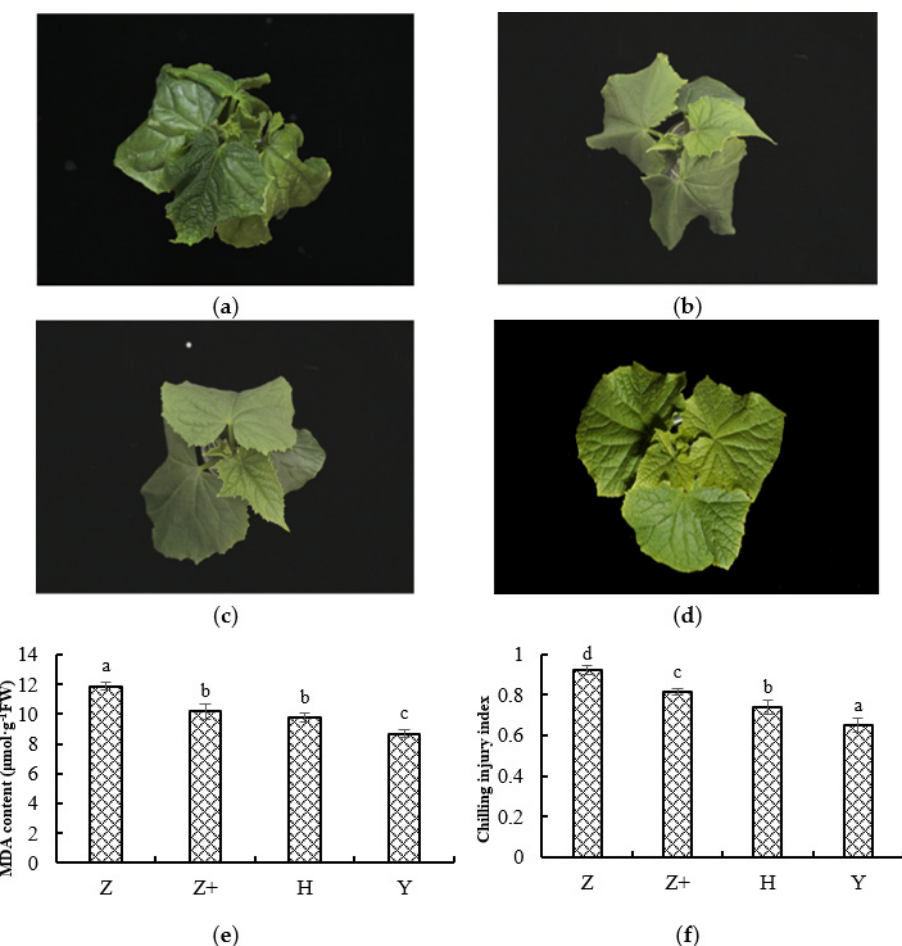
Figure 1. Determination of physiological characteristics under cold treatment. The phenotypes of cucumber seedlings were self-rooted cucumber ( a , Z), self-rooted cucumber with silicon addition ( b , Z+), ‘Huangchenggen No. 2 ′ -grafted cucumber ( c , H) and ‘Yunnan figleaf gourd’-grafted cucumber ( d , Y). MDA content ( e ) and chilling injury index ( f ) of cucumber seedings under cold treatment for 7 days, respectively. Three biological replicates were used, with six plants per replicate. Mean value ± standard deviation were represented, and different letters (a, b, c) indicate that they were significant differences at a level of 0.05, according to Duncan’s test.